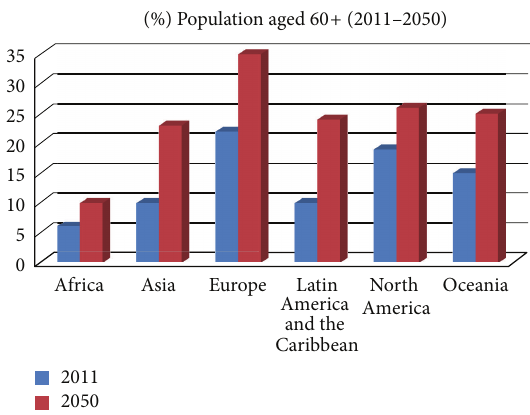
Figure 1: Population aging prospects of the United Nations’ Depart- ment of Economic and Social Affairs. Available online: http://esa.un .org/unpd/wpp/index.htm (last accessed on 10 March